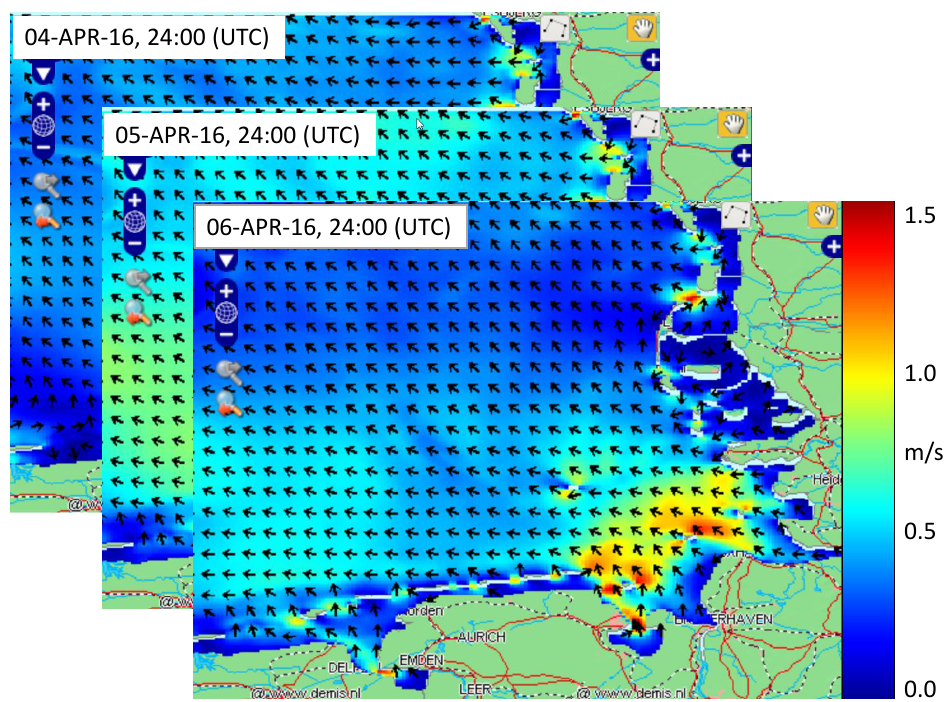
Figure 3. COSYNA product “Surface Current Fields in the German Bight” (snapshot 4–6 April 2016, COSYNA data portal, based on the algorithm described in Stanev et al.,